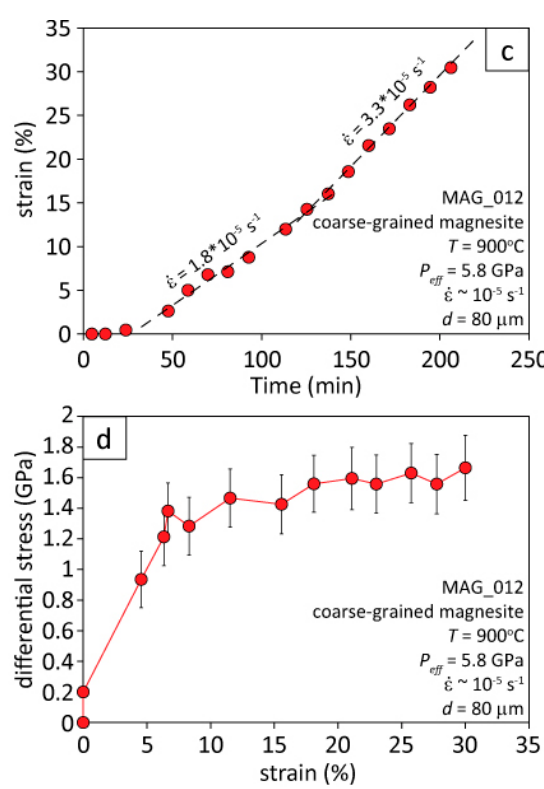
Figure 4. Peaks due to X-ray diffraction from five lattice planes in Al 2 O 3 are used to calculate differential stresses ( a ) and pressure (not shown) during the as a function of time during the experiment. ( b ) The stresses from each lattice plane reflection are averaged to report a differential stress and the range of calculated stresses is listed as the error. ( c ) Strains determined over the same time interval are determined from X-radiographs (as shown in Figure 3) and used to determine the average strain rate. The data from ( b ) and ( c ) can be combined as a stress-strain plot and used to evaluate if the magnesite cylinders deformed at constant stress at the constant strain rate and larger values of strains ( d ).